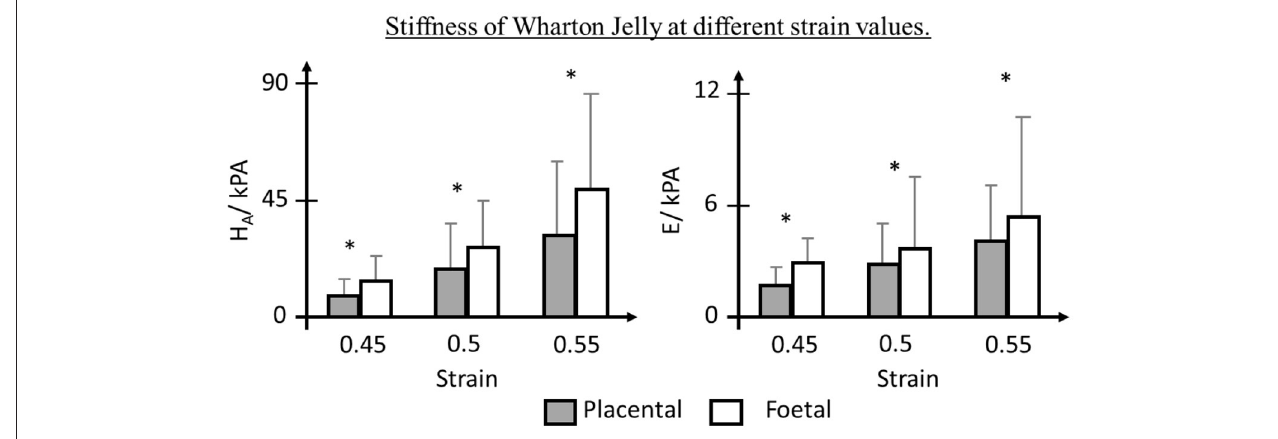
FIGURE 3 | Biomechanics of Wharton Jelly (WJ). WJ near placenta insertion showed lower Aggregate Modulus (H A ) and Young Modulus (E), depicting non-homogeneous mechanical properties (Gervaso et al., 2014). * indicates p <